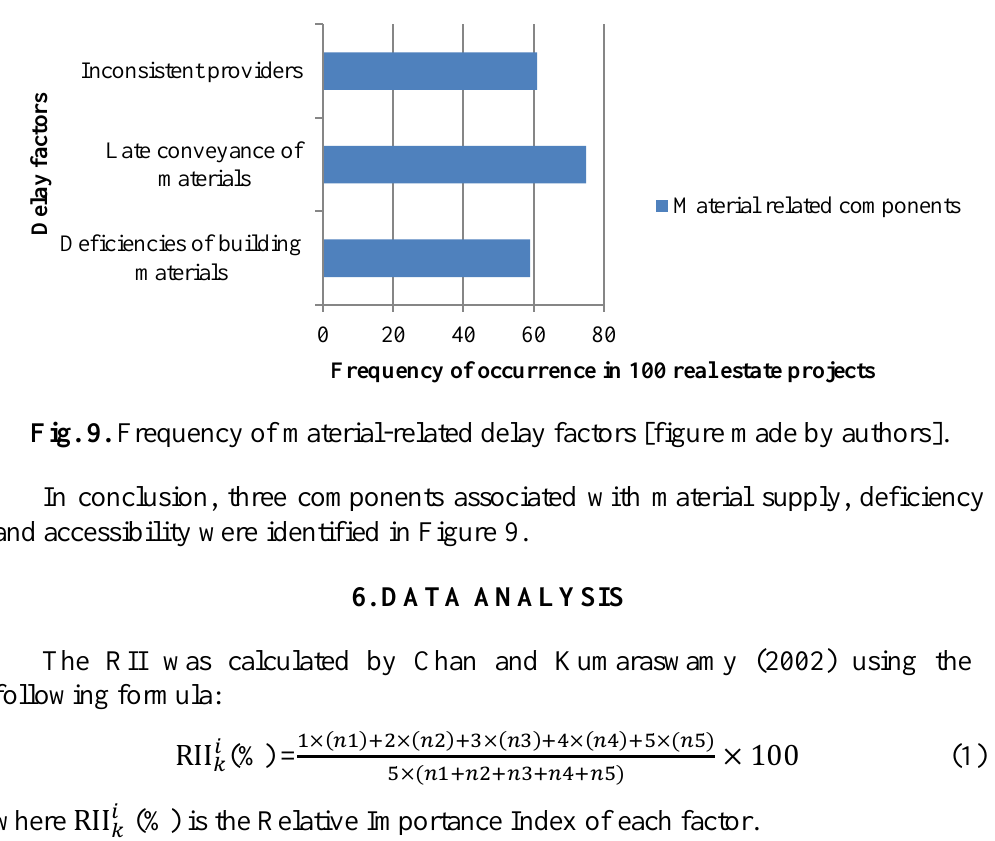
Fig. 8. Frequency of owner-related delay factors [figure made by authors].